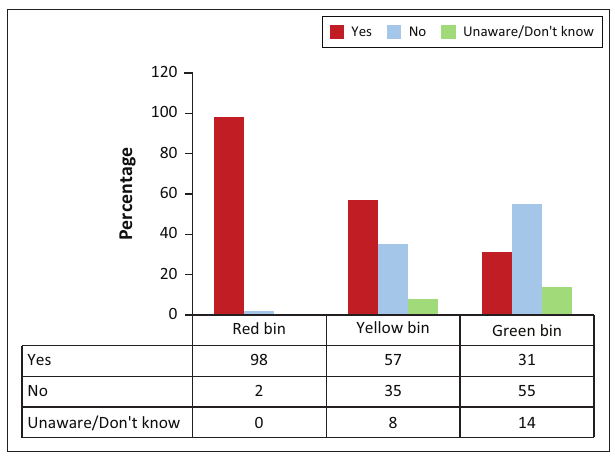
FIGURE 2: Medical waste disposal bins available at participants’ workplace ( n = 49).